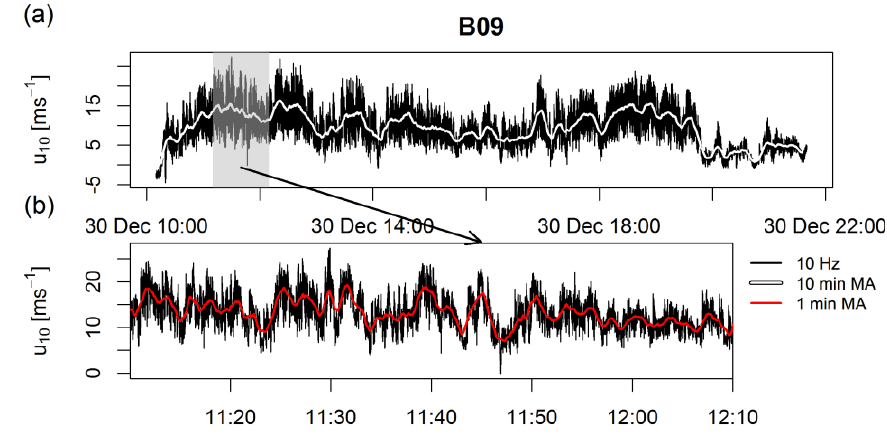
Figure 8. As with Figure 5, but for the bora episode B09 (DA).